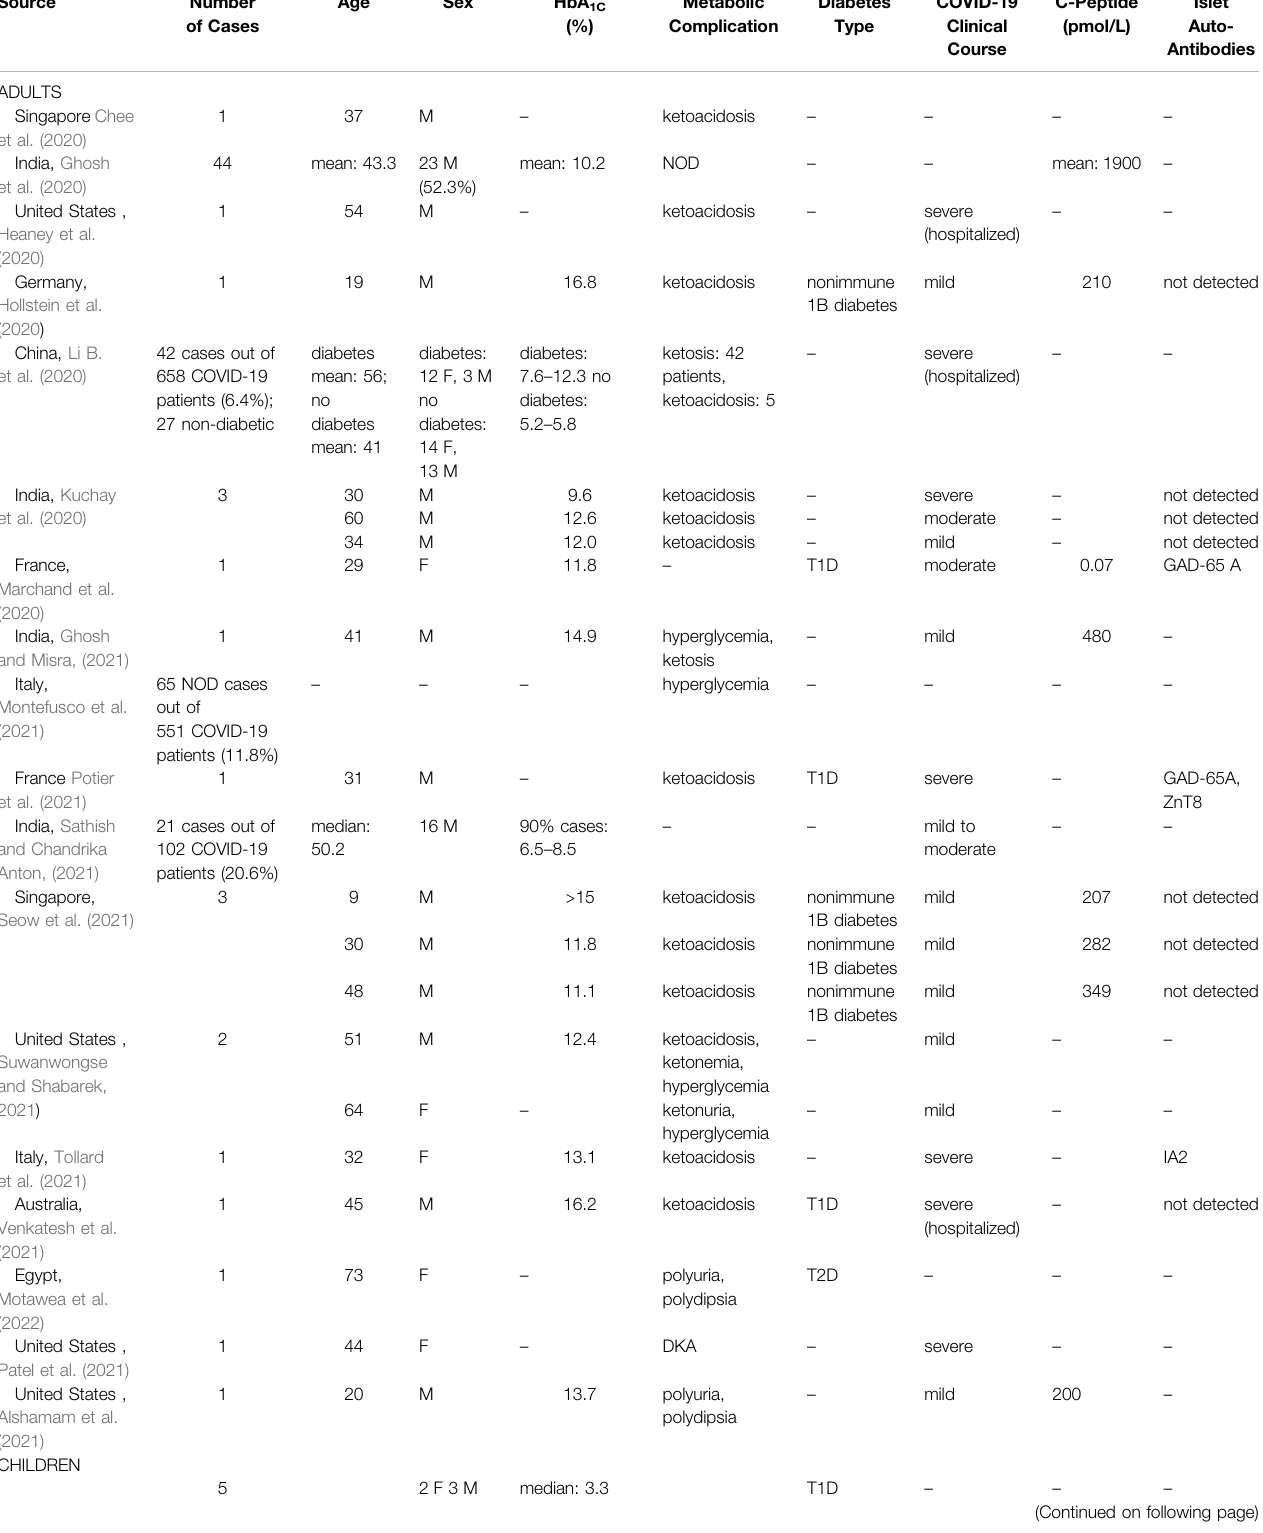
TABLE 2 | New-onset diabetes and diabetic ketoacidosis after SARS-CoV-2 infection. T1D – type 1 diabetes; T2D – type 2 diabetes; GAD-65 A – glutamic acid decarboxylase-65 autoantibodies; IA2 — anti-islet antigen phosphatase; anti- ZnT8 — zinc transporter 8; IAA – antibodies against insulin – no data; M – male; F – female; DKA – diabetic ketoacidosis; NOD – new onset